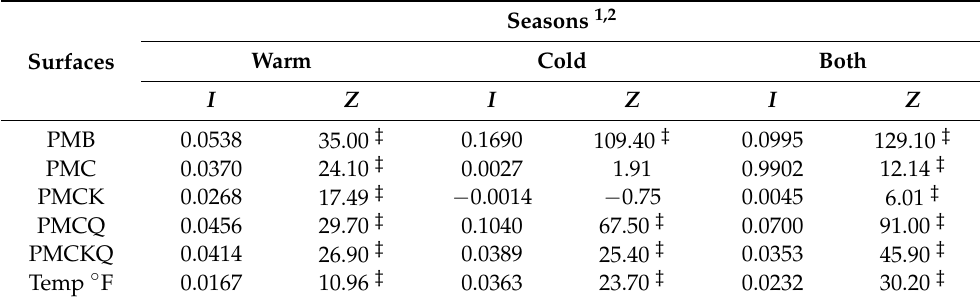
Table 10. Spatial autocorrelations based on Moran’s I for the five fused surfaces and ambient temperature by season in the Baltimore study